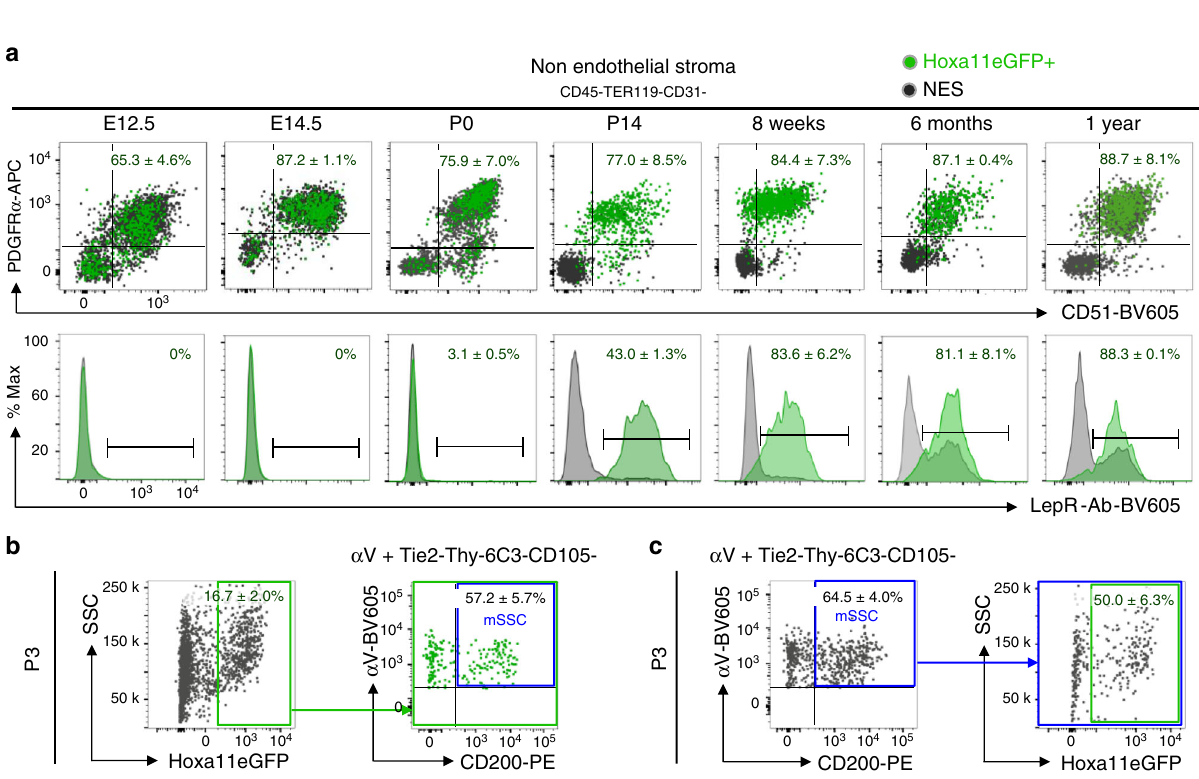
Fig. 2 Hoxa11eGFP-expressing cells co-express MSC markers throughout life. a Flow cytometry analyses of whole skeletal anlage (E12.5 ( n = 4), E14.5 ( n = 6), and P0 ( n = 6). ‘ n ’ values represent pooled cells from both forelimbs of individual embryos or pups) or fl ushed bone marrow (P14 ( n = 9), 8 week ( n = 10), 6 month ( n = 4), and 1 year ( n = 3). ‘ n ’ values represent pooled cells from the radius and ulna of one forelimb of individual animals). Gating strategy and bone surface analyses Supplementary Fig. 1a, b. Non-hematopoietic, non-endothelial stromal compartment (CD45-TER119-CD31-) was gated on PDGFR α /CD51 (top) or Leptin Receptor (LepR-Ab, bottom). Percentages re fl ect proportion of Hoxa11eGFP-positive population within double-positive gate (top) or bracketed region of histogram (bottom). Charcoal dots or gray histogram: total non-endothelial stroma (NES), green dots or green histogram: Hoxa11eGFP-expressing non-endothelial stroma (Hoxa11eGFP + ). b , c Flow cytometry analyses of whole P3 bones [ n = 3]. ‘ n ’ value represents pooled cells from the radius and ulna of both forelimbs of individual pups. Gating strategy Supplementary Fig. 1c. Non-hematopoietic, non-endothelial stromal compartment (CD45-TER119-CD31-) was gated for b Hoxa11eGFP-positive population (green box) and subsequently for mouse skeletal stem cells (mSSCs, α V + Tie2-Thy-6C3-CD105-CD200 + , blue box) or c mSSC population (blue box) and subsequently for Hoxa11eGFP-expression (green box). Percentages re fl ect proportion of cells within indicated gate. ‘ n ’ values indicate biologically independent animals for each time point. All data presented as mean ± standard